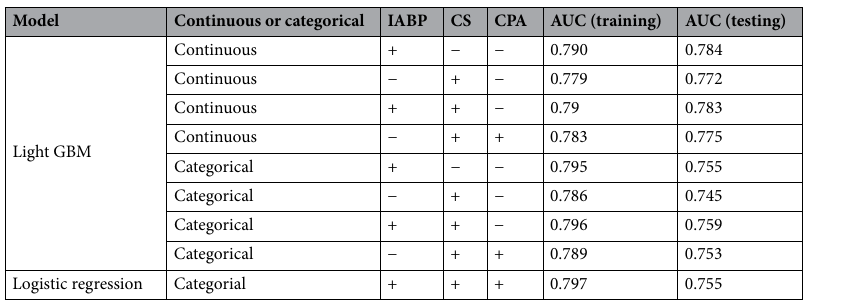
Table 3. Area under the curve in different models. AUC, Area under the curve; CS, cardiogenic shock; CPA, cardiopulmonary arrest; GBM, gradient boosting model; IABP, intra-aortic balloon